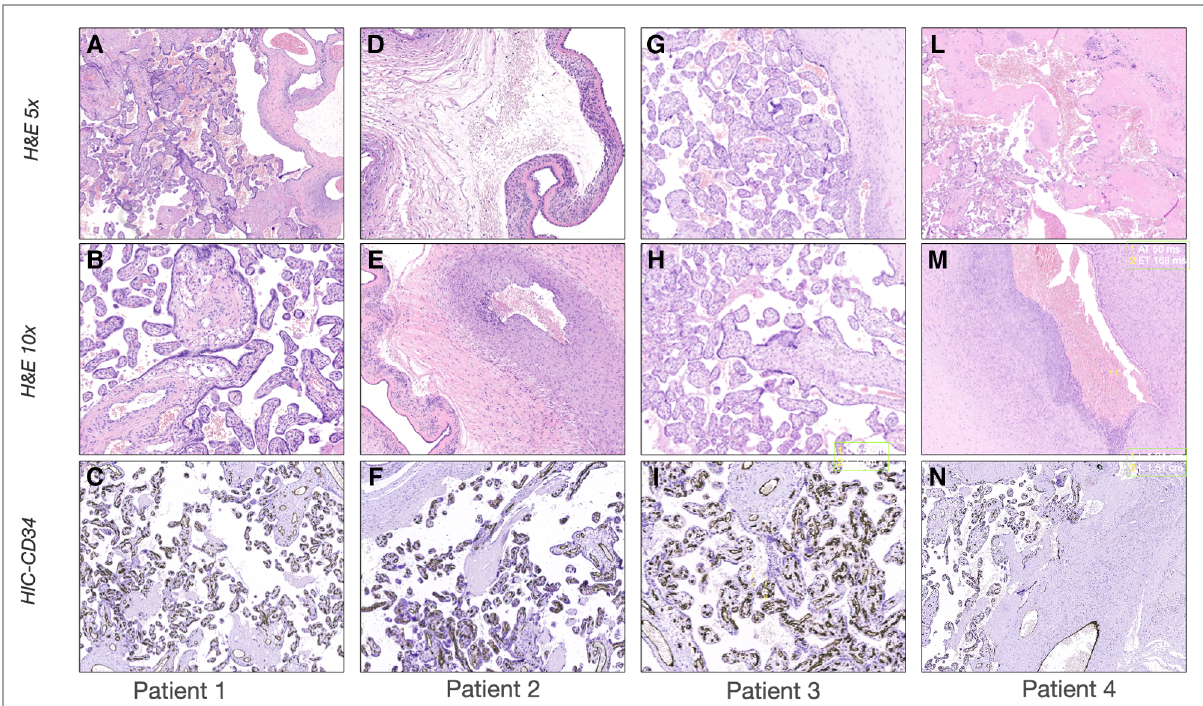
FIGURE 1 Sonographic patterns of bronchodysplasia (BPD). Representative pictures of Lung Ultrasound (LUS) and echocardiography of the patients at the time of the beginning of therapy. ( A – C ) Case 1: ( A ) LUS showing homogenously and gravity-related distributed B-lines with a normal pleural line; ( B ) color- Doppler of the pulmonary artery showing normal fl ow; ( C ) B-mode evaluation of ventricular chambers showing normal eccentricity index (EI). ( D-F ) Case 2 : ( D ) LUS showing inhomogeneous B-line distribution with spared areas of normal sonographic lung appearance, surrounded by areas containing multiple B-lines. Pleural line thickened and irregular; ( E ) color-Doppler of the pulmonary artery showing normal fl ow; ( F ) B-mode evaluation of ventricular chambers showing normal EI. ( G-I ) Case 3 : ( G ) LUS homogenously and gravity-related distributed B-lines with subpleural atelectasis of the dependent regions; ( H ) color-Doppler of the patent ductus arteriosus showing pulsatile fl ow; ( I ) M-mode evaluation of the left atrium (LA) to aorta (Ao) ratio, showing important dilation of the ratio atrium (LA:Ao=2); ( L-N ) Case 4 : ( L ) LUS showing con fl uent B- lines with sparing areas, thickened pleural line, and with subpleural atelectasis; ( M ) color-Doppler of the pulmonary artery showing decreased acceleration time/ejection time (AT/ET)=0.28; ( N ) B-mode evaluation of ventricular chambers showing decreased EI